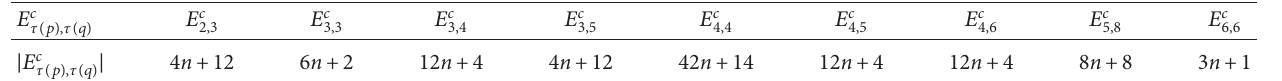
Table 8: Partition of K ’s edges according to the connection number.